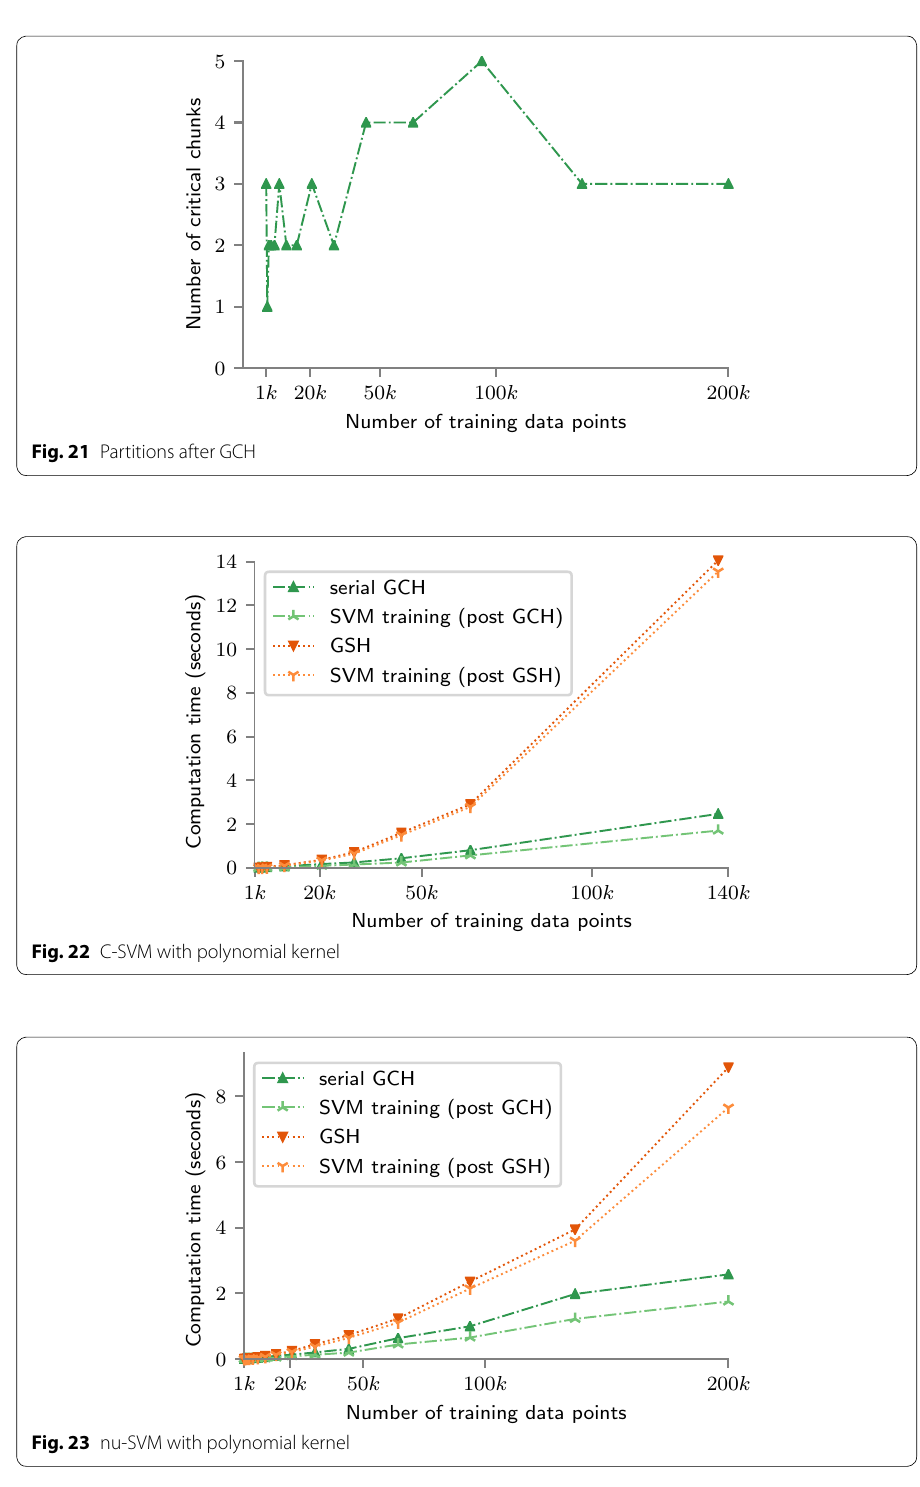
Fig. 23 nu-SVM with polynomial